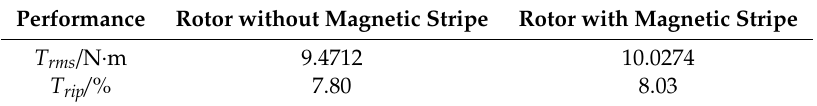
Table 3. Torque performance comparison of motors with or without magnetic stripe